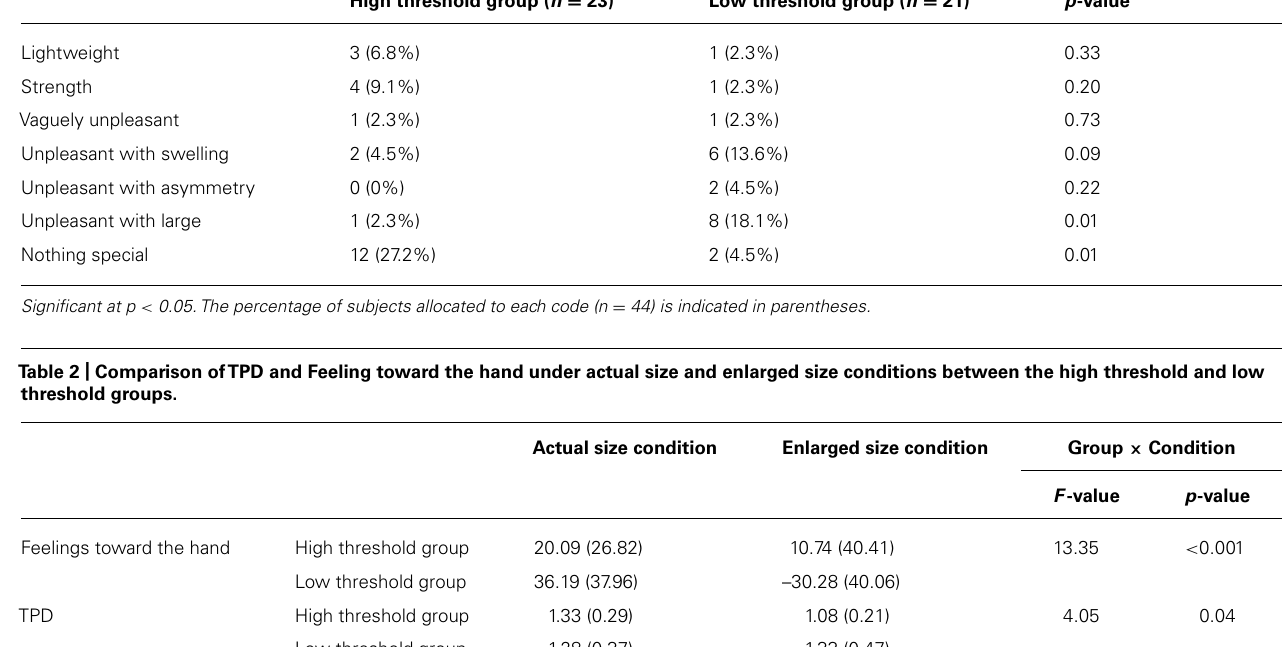
FACTORS ASSOCIATED WITH INCREASED PAIN ON VISUALIZATION OF A MAGNIFIED MIRROR IMAGE OF THE HAND